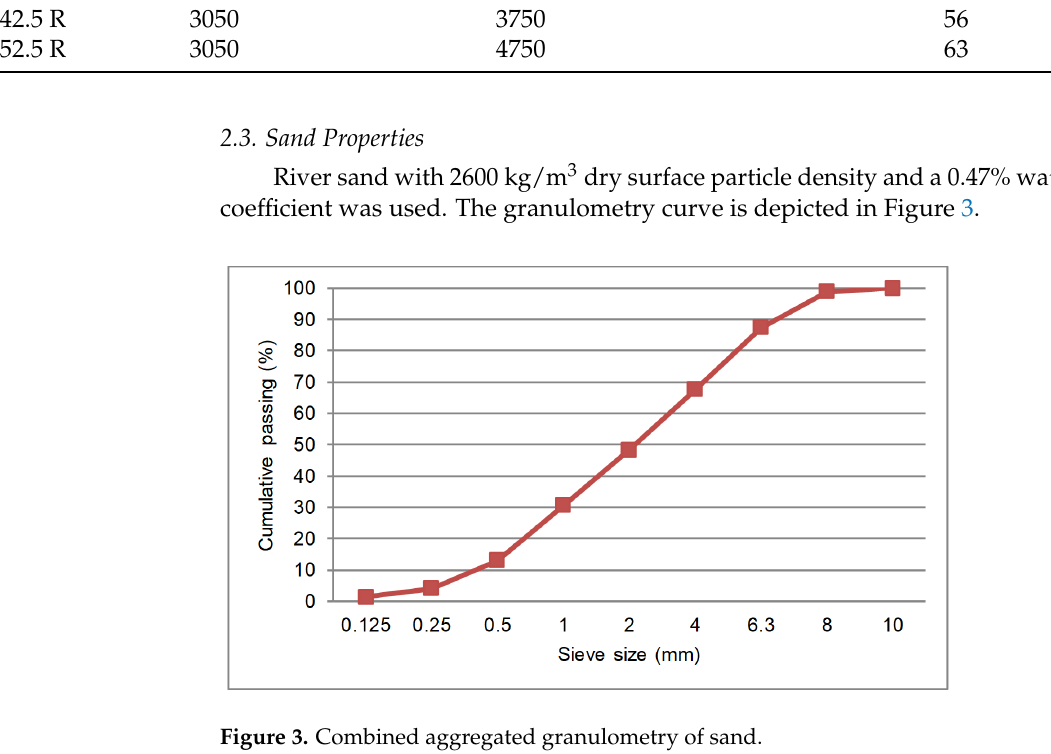
Figure 3. Combined aggregated granulometry of